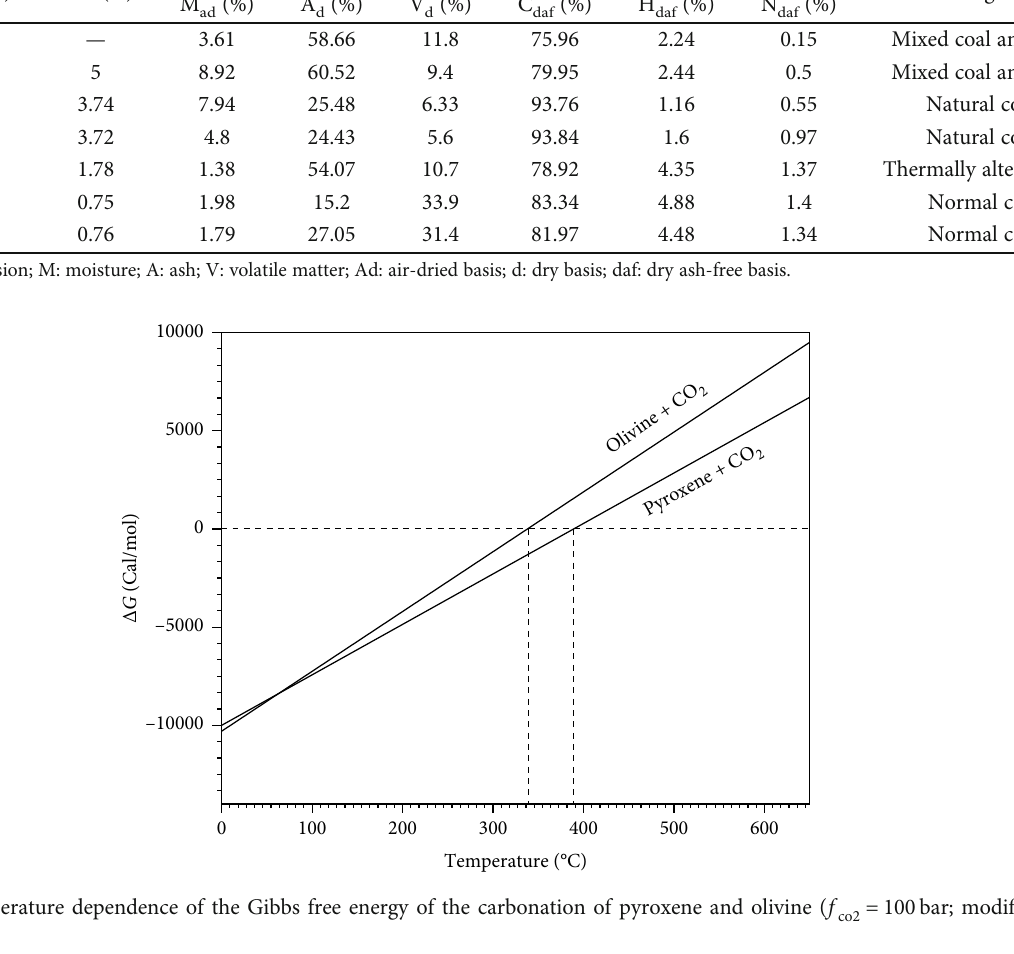
Figure 11: Temperature dependence of the Gibbs free energy of the carbonation of pyroxene and olivine ( f Marini